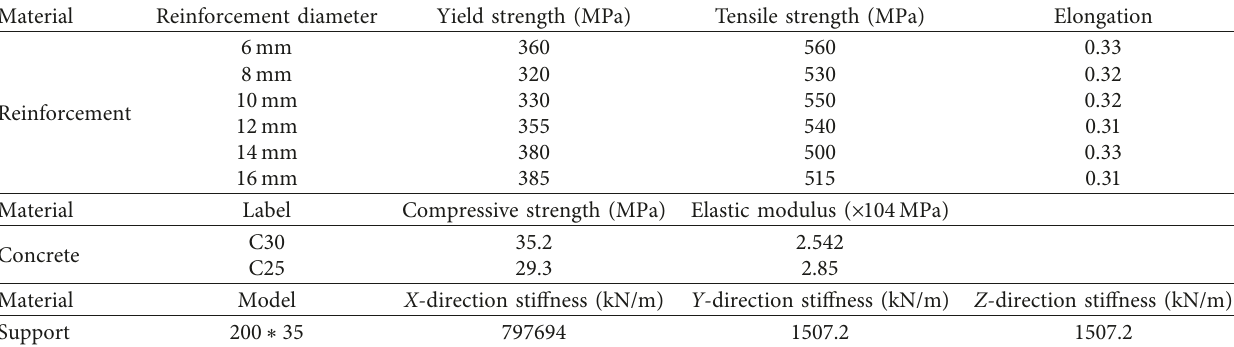
Table 2: Main material mechanics index of the skew bridge